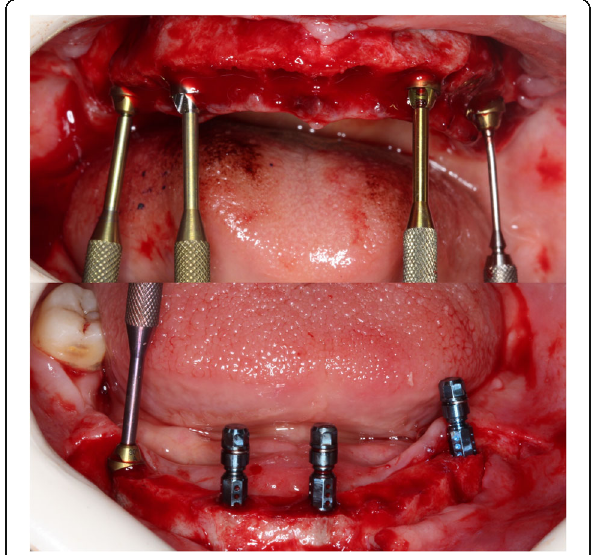
Fig 3 Insertion of implants, placement of SRA abutments in